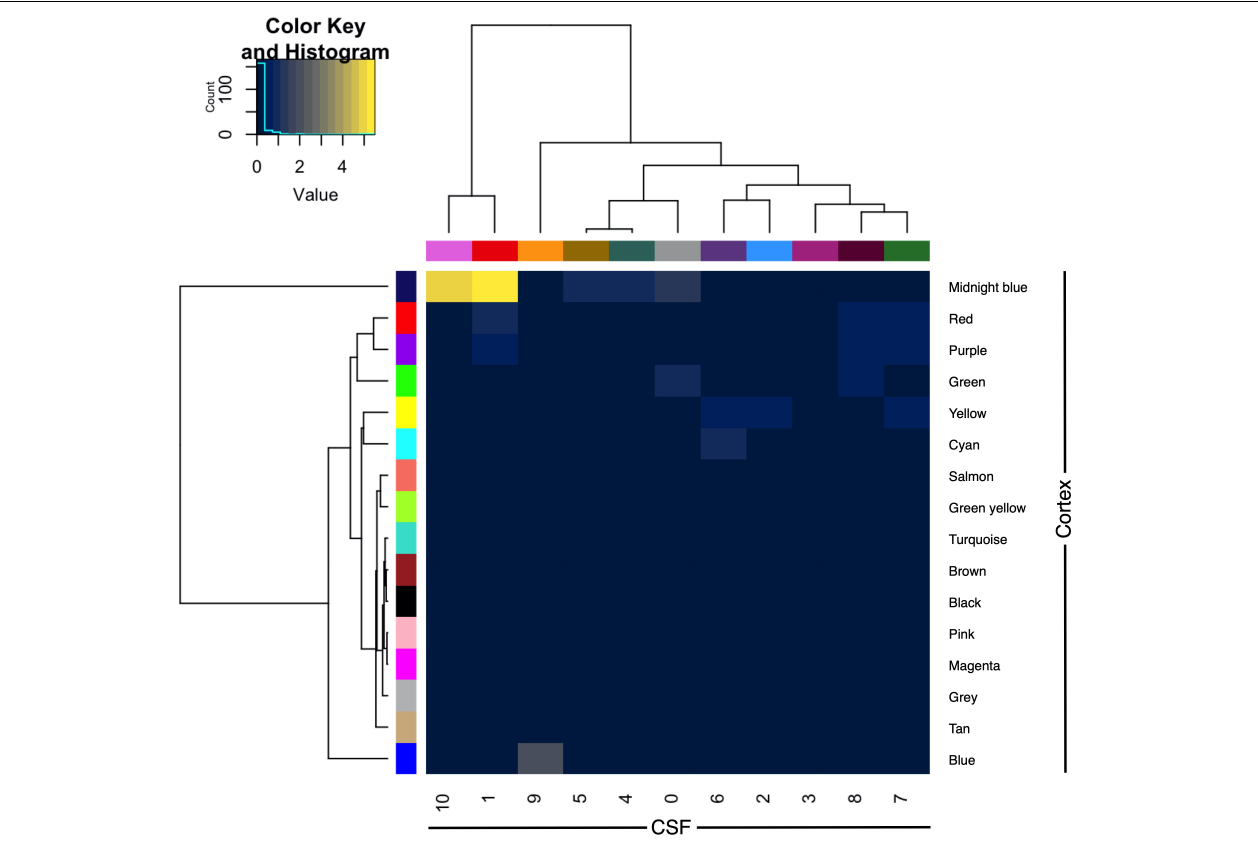
FIGURE 5 | Module preservation of CSF (columns) and frontal cortex (rows) by cross-tabulation. Significant overlaps were observed between CSF modules 1 and 10 with frontal cortex module 9 (midnight blue). Color indicates –log 10 p -value for enrichment. CSF, cerebrospinal